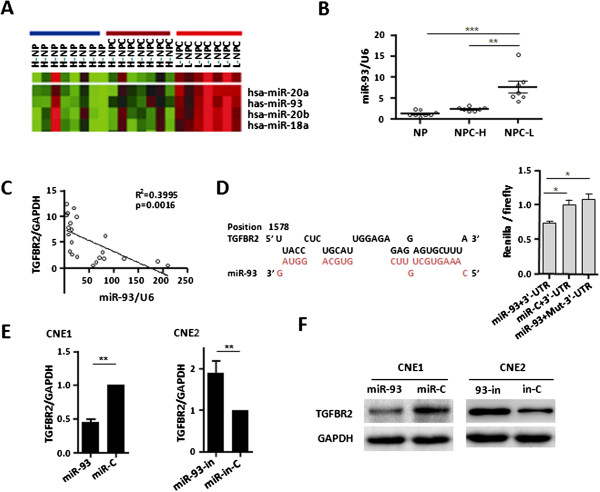
miR-93 directly suppresses TGFβR2 in NPC. (A) miRNA expression profiling analysis in three subgroups of clinical samples including 8 NP with high TGFβR2 expression (H-NP, a blue bar on top), 7 NPC with high TGFβR2 expression (H-NPC, a brown bar on top) and 7 NPC with low TGFβR2 expression (L-NPC, a red bar on top). (B) qRT-PCR validation of miR-93 expression in 22 clinical tissue samples. Values represent mean ± SD, n = 3. **P < 0.01. ***P < 0.001. (C) Correlation analysis between TGFβR2 and miR-93 in 22 clinical tissue samples. (D) RNAhybrid prediction of the binding sites of miR-93 in the 3′ UTR of TGFβR2. Luciferase activities of dual luciferase reporter carrying a wild-type or mutant of TGFβR2 3′ UTR in the indicated cells in triplicate. Values represent mean ± SD. *P < 0.05. (E, F) The detection of TGFβR2 mRNA and protein expressions by qRT-PCR and Western blot in CNE1 and CNE2 cells transfected with miR-93 mimic and inhibitor respectively. Values represent mean ± SD, n = 3. **P < 0.01.